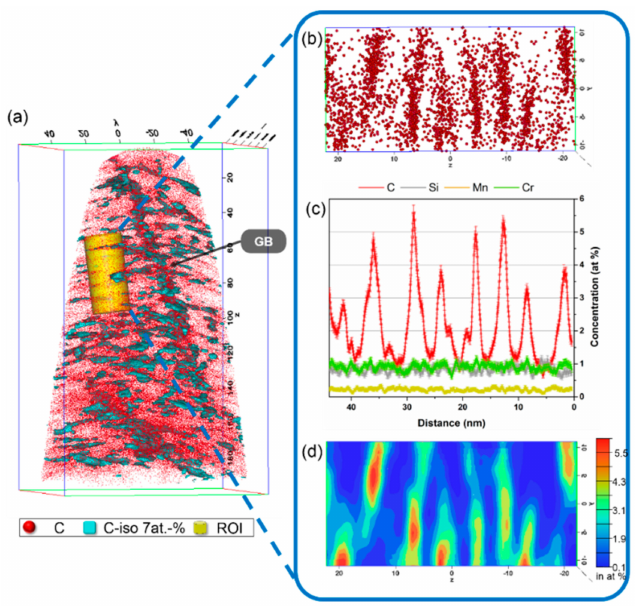
Figure 4. ( a ) 3D carbon atomic map, 7 at% iso-concentration surfaces and marked ROI in 100Cr6 in the as-quenched condition subsequent to austenitization; ( b ) the atomic illustration of carbon along the z-axis of ROI; ( c ) the corresponding 1D-concentration profile; and ( d ) the corresponding 2D-concentration map; GB represents grain